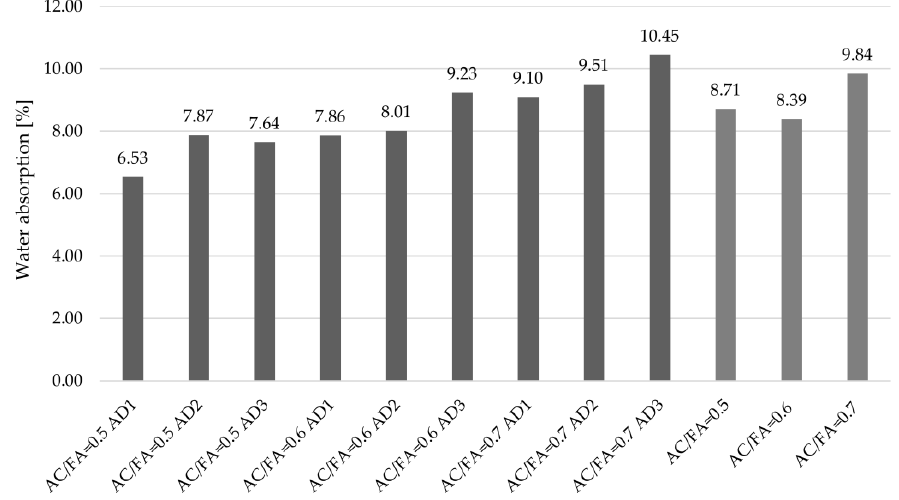
Figure 5. Water absorption results for all the series.